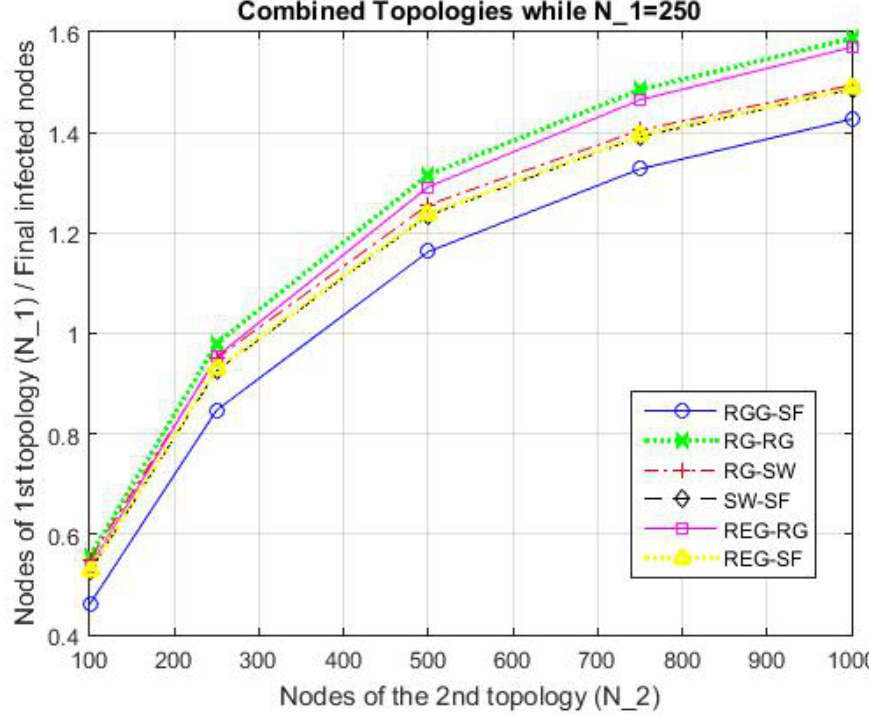
Figure 9. Spread of malware while the nodes of the 1st topology remain equal to N_1 =